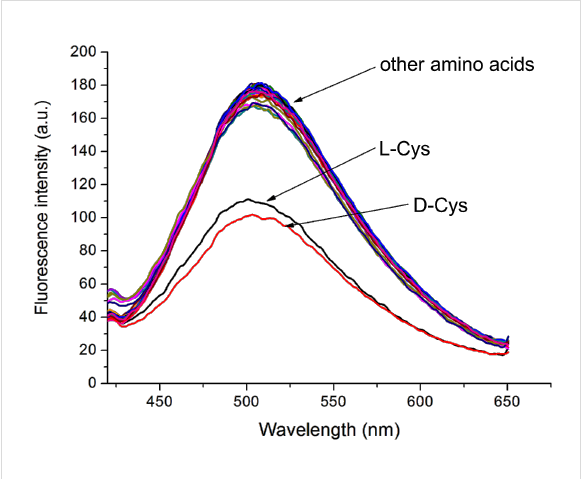
Figure 6: Fluoresence emission change of Cd 2+ – ACAQ at 500 nm in response to the addition of 15 equiv amino acids in 1:99 ACN:HEPES buffer solution (pH 7.4) at 298 K (excitation at 350 nm): 1. D-Cys; 2. L-Cys; 3. GSH; 4. L-Met; 5. DL-Hcy; 6. N -Ac-L-Cys; 7. MPA; 8. L-Asp; 9. D-Asp; 10. D-Glu; 11. L-Glu; 12. D-Lys; 13. L-Lys; 14. D-Ser; 15. L-Ser; 16. D-Tyr; 17. L-Tyr; 18. D-Val; 19. L-Val; 20. D-Phe; 21. L-Phe;